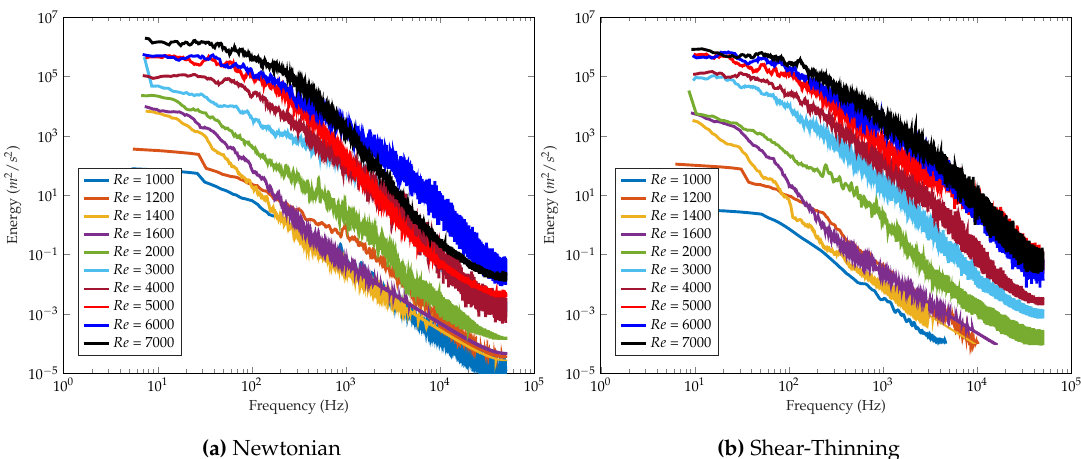
Figure 14. Mean TKE spectra for each Reynolds number. Newtonian blood rheology (a) and shear-thinning blood rheology (b).